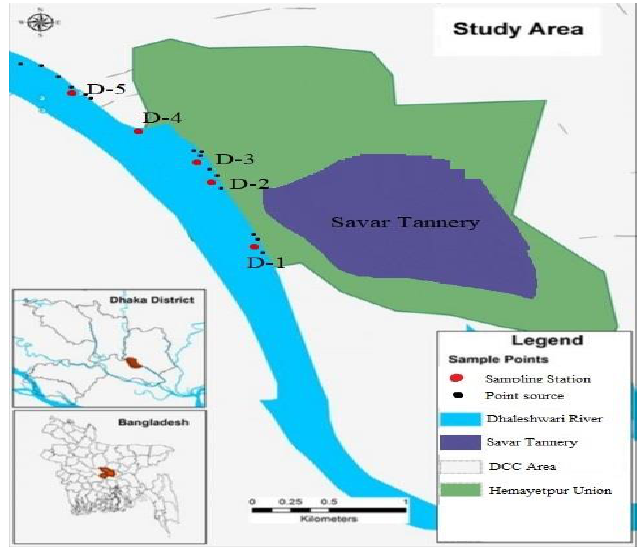
Figure 1. GIS Map of the Sampling Stations along Dhaleshwari River. Identified sampling stations were selected based on the intensity of industrialized zones and presence of waste disposal points beside the banks of the rivers. In the present study, five of the following places along the river were chosen: Savar Tannery (D-1), Sudkhira (D-2), Dhalla (fish market) (D-3), AKS dying (D-4), and Nama Bazar (D-5) at Savar district in Bangladesh (Figure 1). Global positioning system (GPS) coordinates were used to precisely locate each sampling station. The identification of the sampling stations and distances from the Savar Tannery are provided in Table